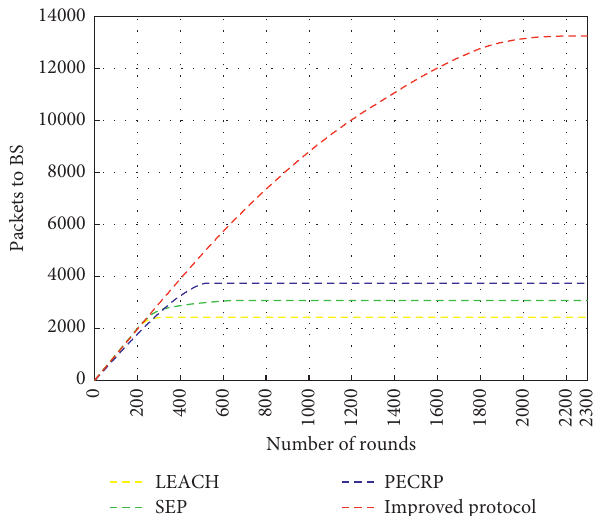
Figure 17: Comparison of packets sent to BS from CHs with power